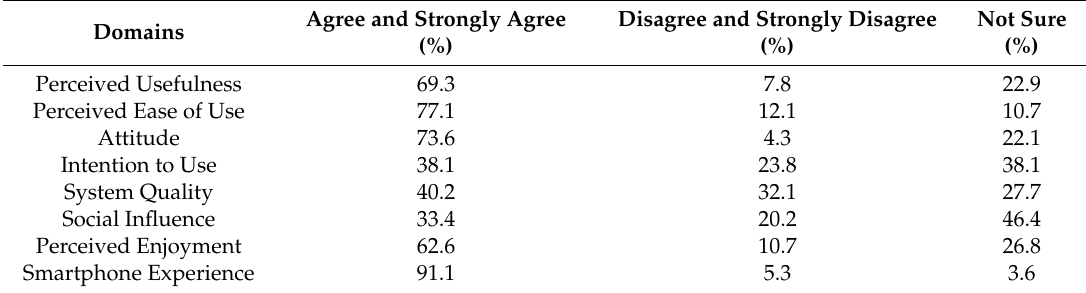
Table 2. Level of acceptability towards the food app using the modified TAM 1 questionnaire ( n = 28).